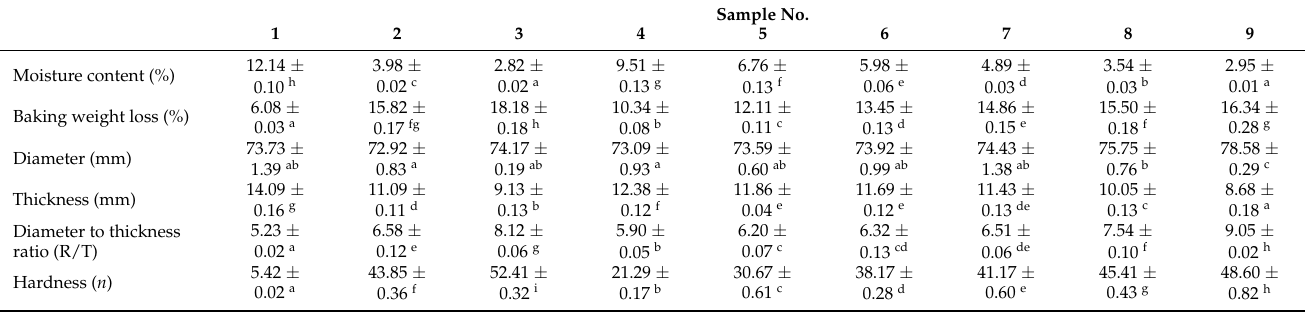
Table 4. Technological quality responses of cookies with and without the addition of L and OL peach.